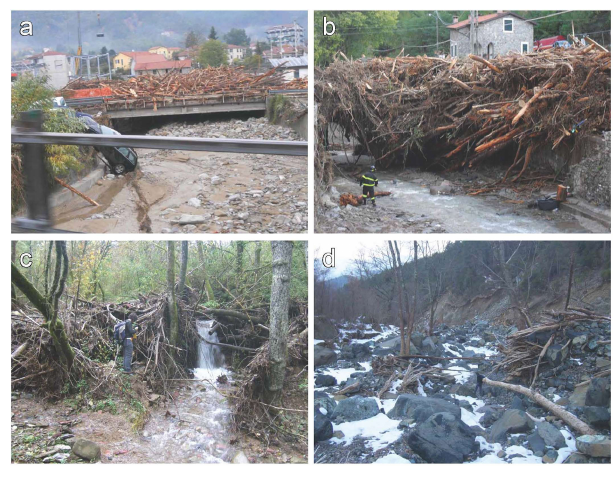
Figure 1. (a) LW clogging in the Magra river catchment after the 2011 flash flood, upstream view of a bridge in the town of Brug- nato. Note also the evident sediment deposition below the bridge; (b) downstream view of a huge wood jam trapped by a bridge in the village of Pignone; source: Autorità di Bacino Interregionale del Fi- ume Magra and Provincia della Spezia. (c) A LW jam anchored on remaining vegetation, it retained sediment upstream; (d) LW jam deposits anchored by the remaining